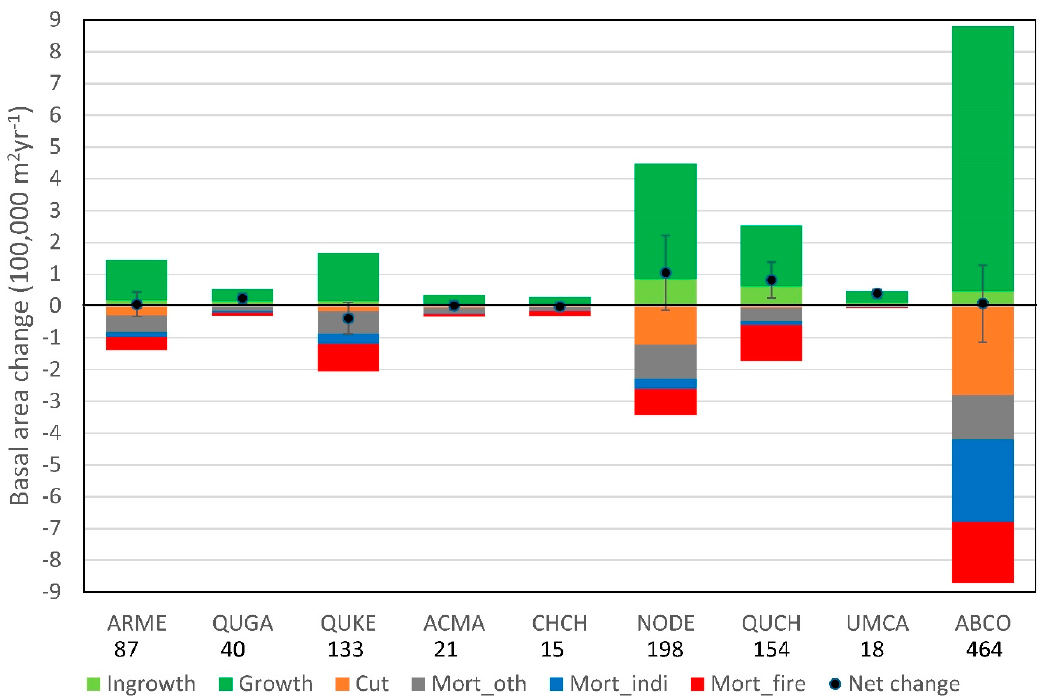
Figure 6. Overall change in basal area, and changes associated with particular causes of mortality (abbreviated terms in legend are defined in Figure 4), from time 2 to time 3 for eight hardwood species and white fir (ABCO). Number under species code is live basal area (×100,000 m 2 ) at beginning of time 2, and error bars on the net change values represent the 95% confidence interval.